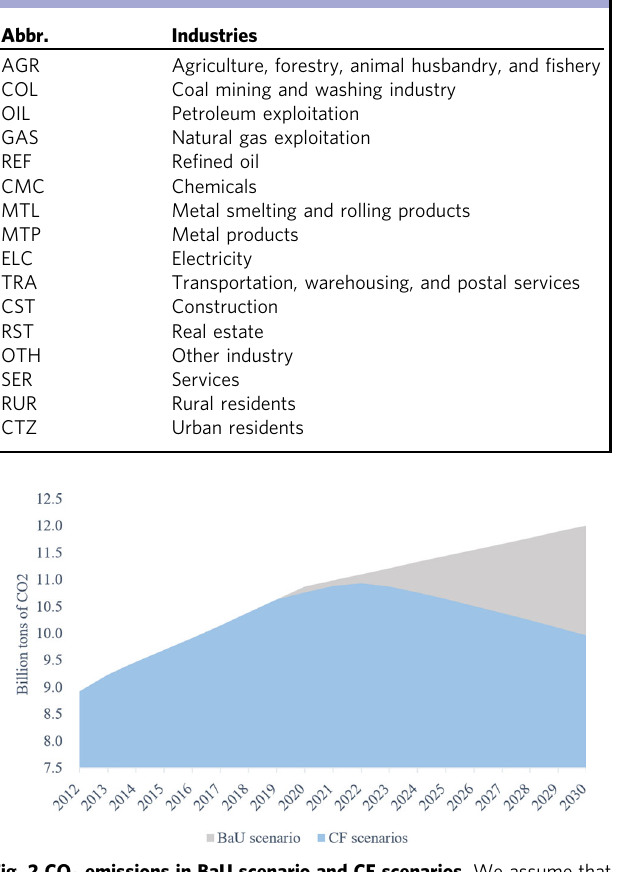
Fig. 2 CO 2 emissions in BaU scenario and CF scenarios. We assume that the CO 2 emissions will peak in 2022 in all counter factual scenarios imposing resource tax or carbon tax, while there is no peak in CO 2 emissions in BaU